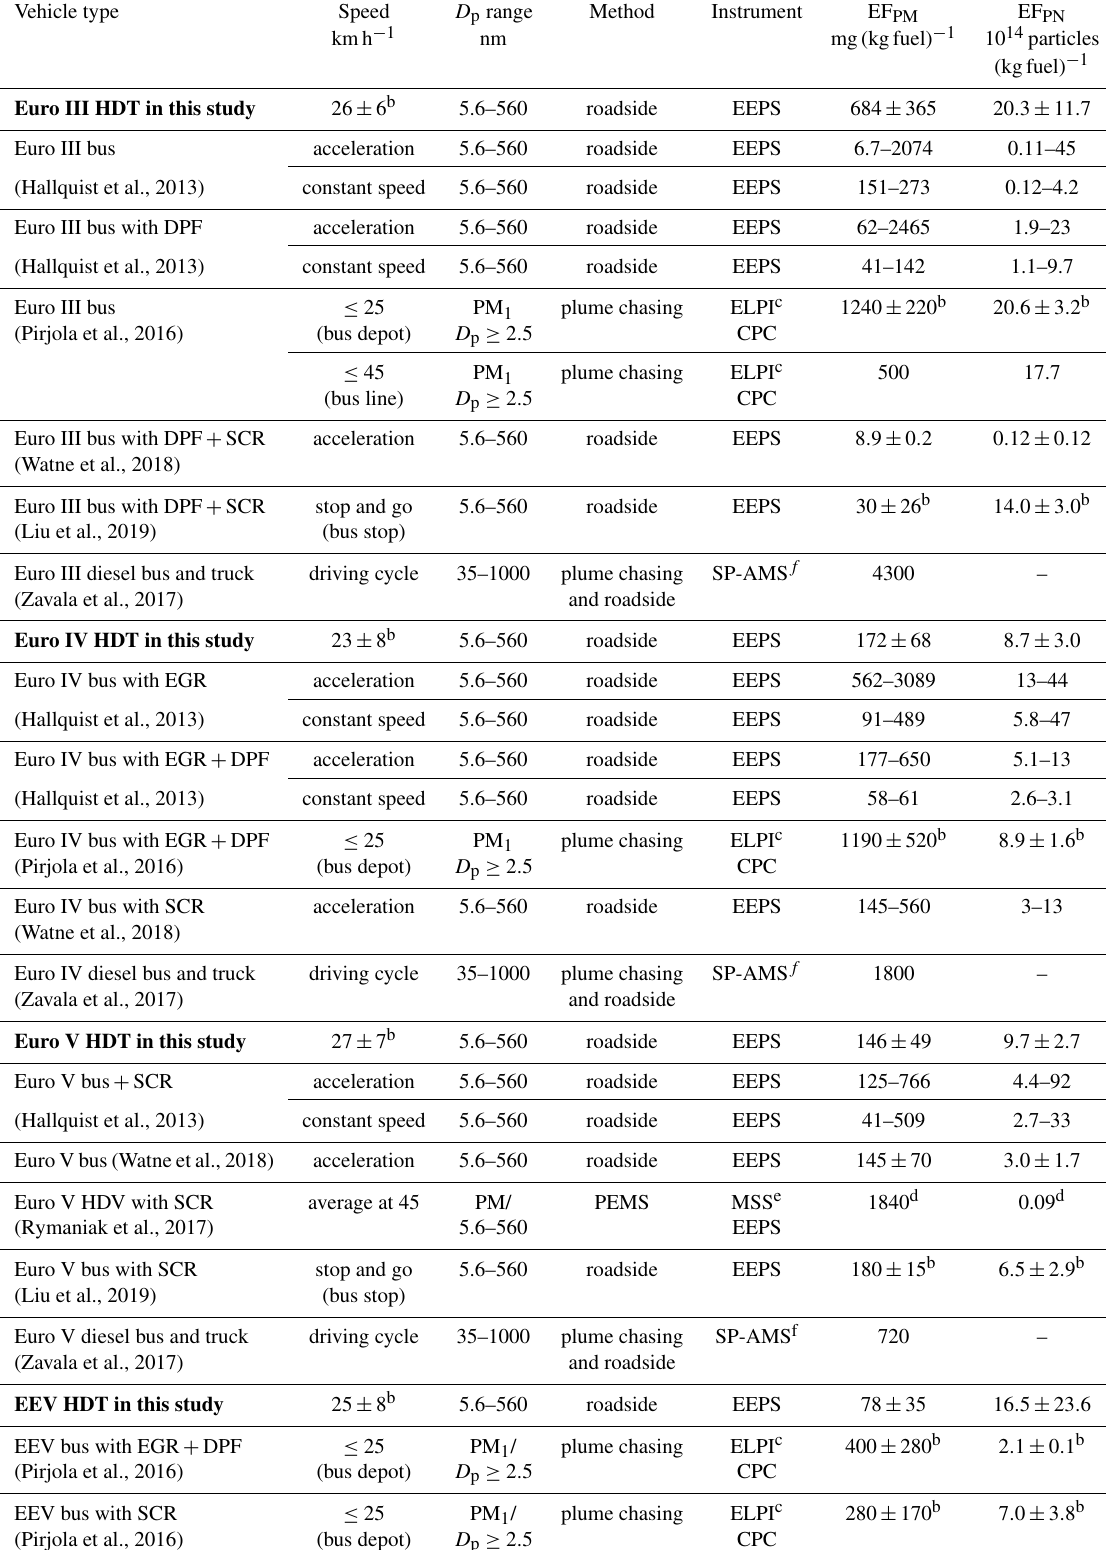
Table 1. Comparison of the average emission data a for PM and PN from the present study with literature data. Bold font was used for better illustration of different Euro